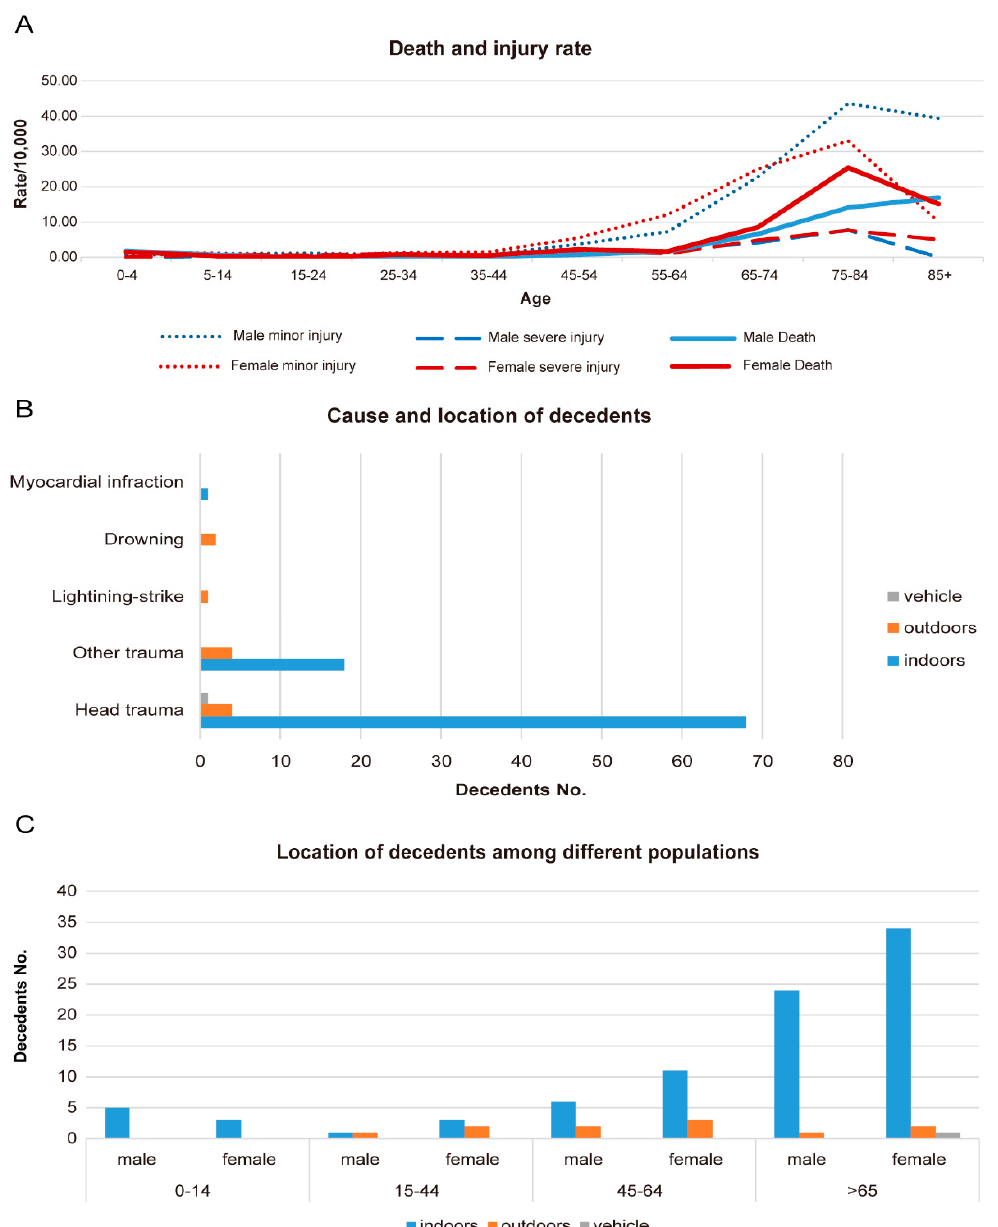
Figure 2. Characteristics of deaths and injuries of the tornado in Funing, 23 June 2016. ( A ) Death and injury rate among males and females; ( B ) cause and location of decedents; ( C ) location of decedents among different age and gender groups.